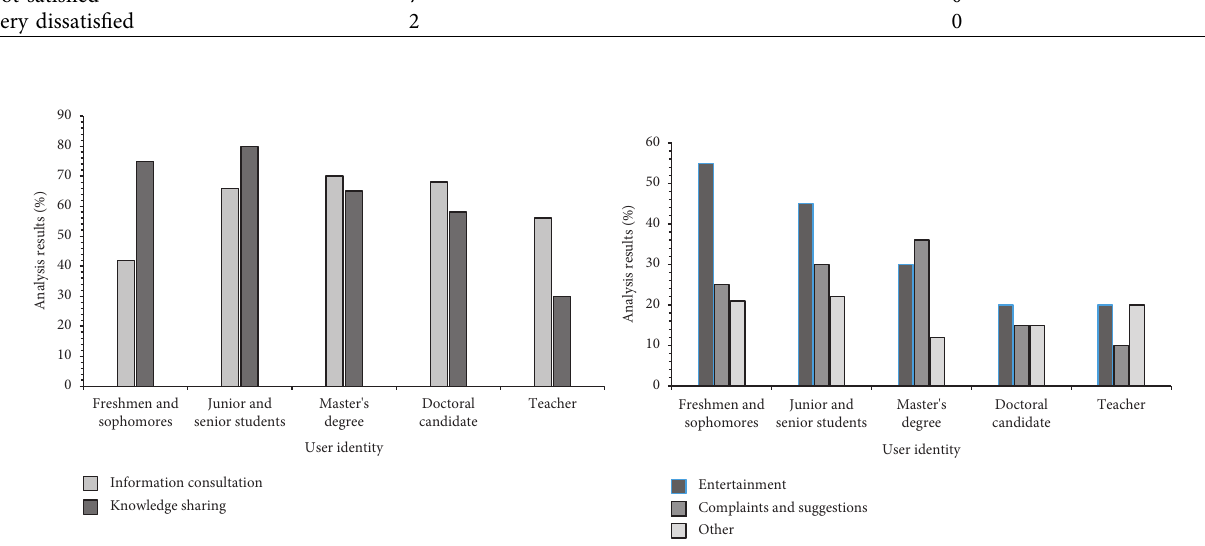
Figure 10: Purpose analysis of interaction between library